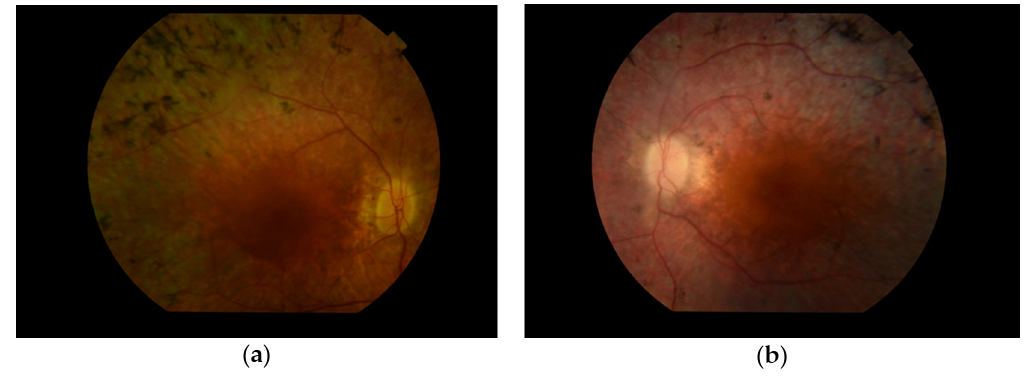
Figure 4. Fundus photographs of the right ( a ) and left ( b ) eye.